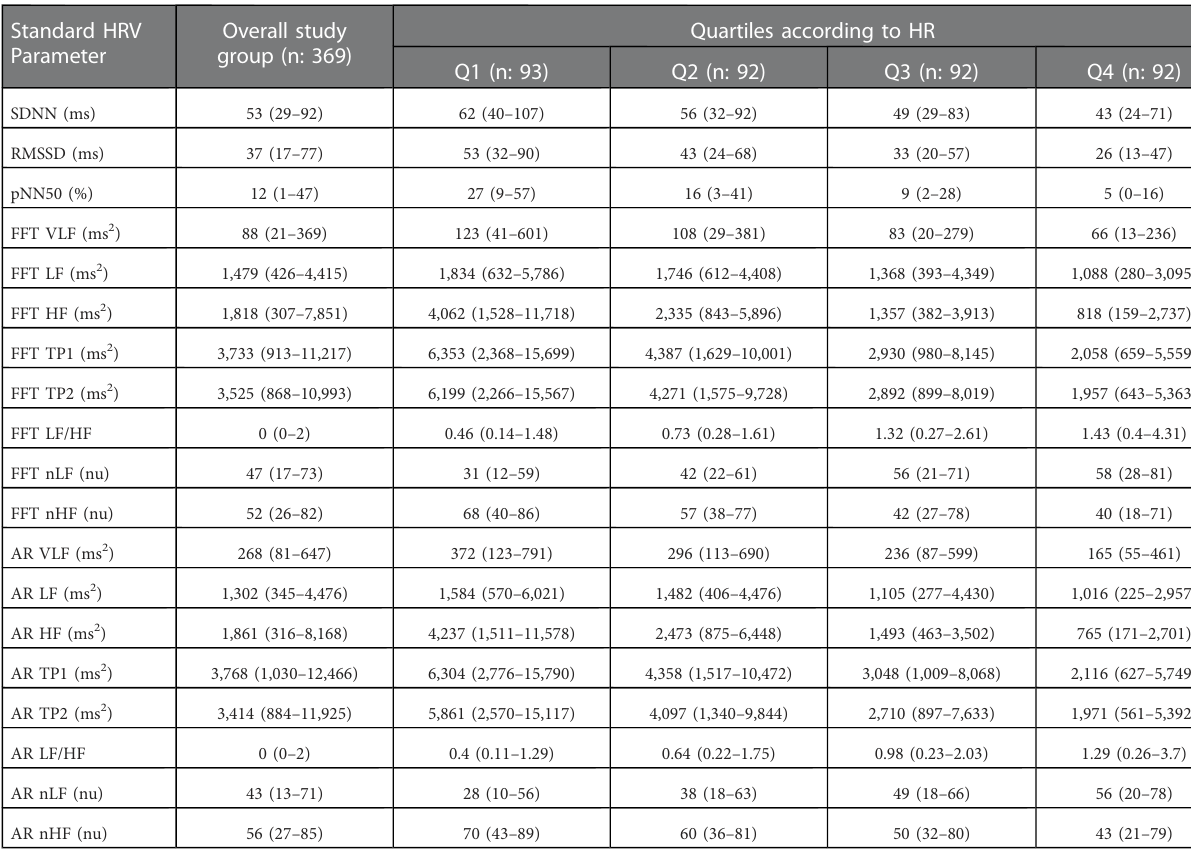
TABLE 4 Normative standard time and frequency-domain HRV parameters values for overall study group and according to heart rate quartiles are presented as median, 5th – 95th percentiles. Standard HRV Overall study Parameter group (n: